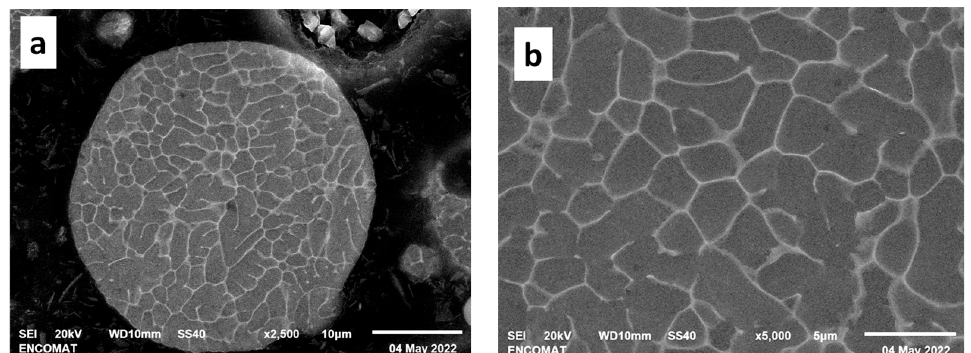
Figure 2. SEM images of the fine solidification microstructure of AA7075 pre-alloyed powders: ( a ) cross section of the powder particle after etching with NaOH; ( b ) detailed image ( a ) showing the dimensions of the dendrites.